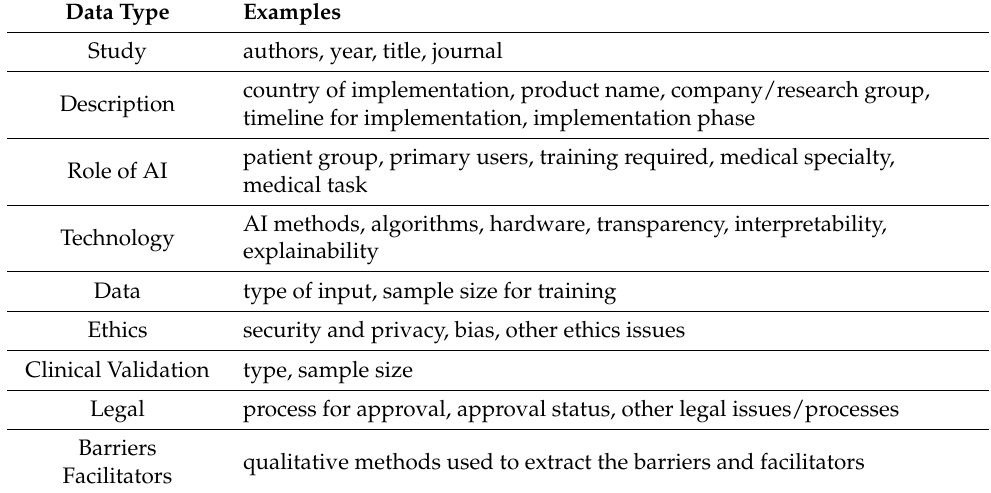
Table 2. Data extraction